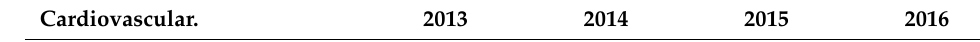
Table 4. Number of admissions in ER for CVD diseases.